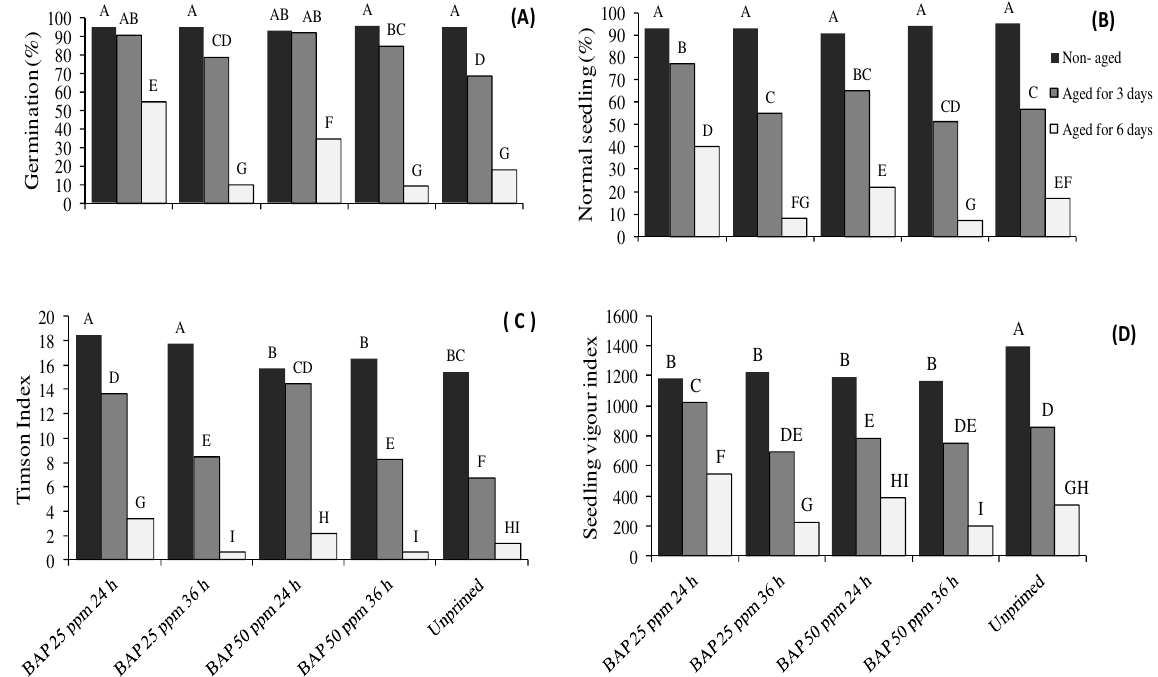
Fig. 1. Germination (%) (A), normal seedling (%) (B), Timson index (C) and seedling vigour index (D) of unprimed and primed Tall wheatgrass seeds subjected to 0, 3 and 6 days accelerated aging. Priming treatments were BAP 25 and 50 ppm for 24 and 36 h at 10